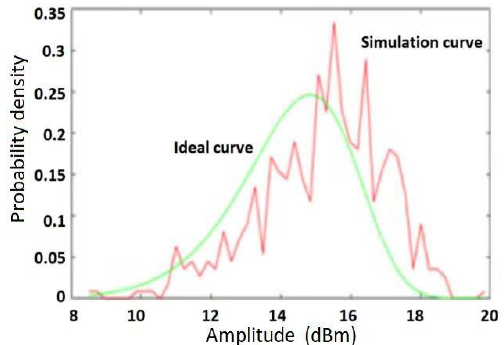
Figure 13. Comparison of complex Weibull clutter and ideal Weibull curve generated by the ground clutter modeling method.